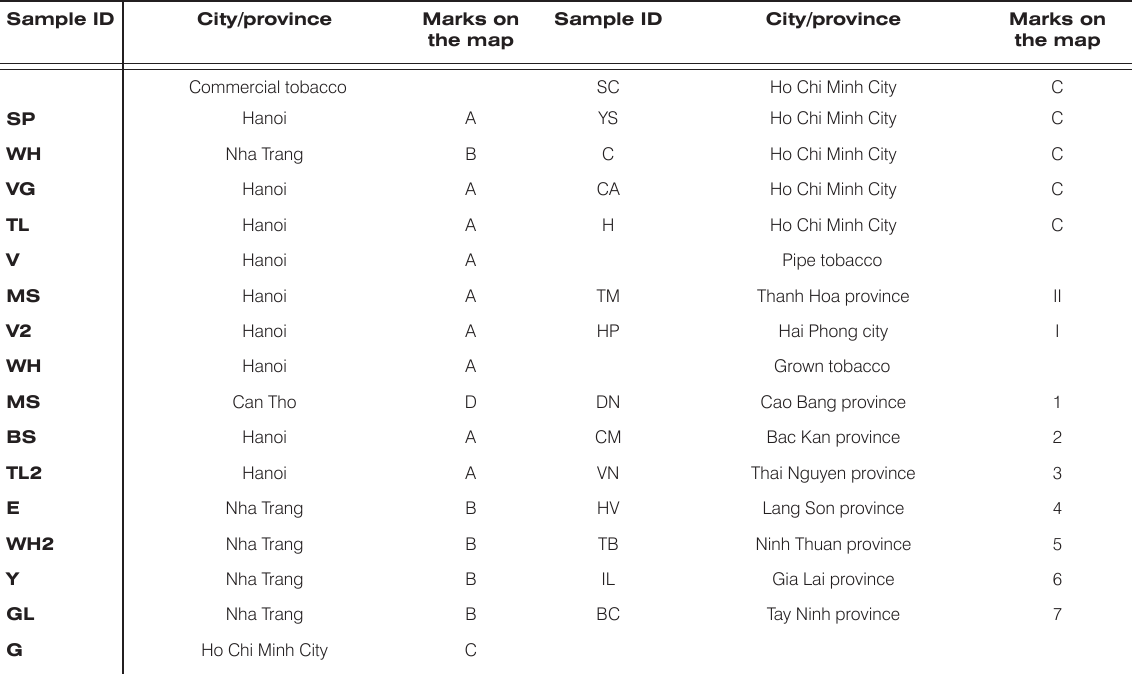
Table 1. ID of samples. Sample